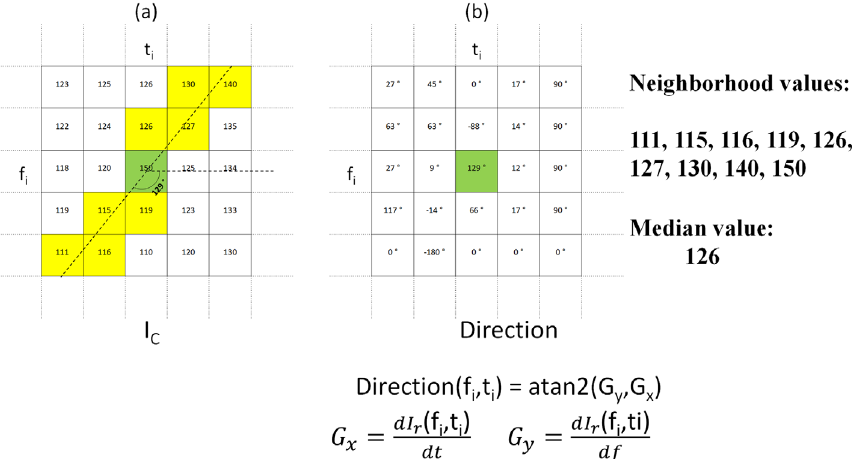
Fig. B.1. Calculating the median value of a pixel neighborhood I r ( x i , y i ). As can be seen, the pixel value of 150 (outlier value) is replaced with the median value: 126. Squares neighborhood around the calculated Direction( f i , t i ) (129 (cid:3) ), are used